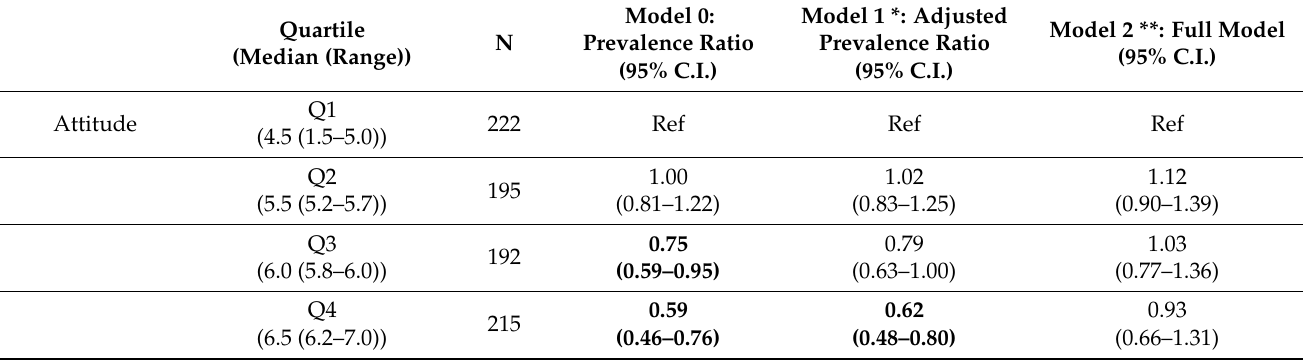
Table 3. Association between eight behavioral determinants and outcomes of the Pro55+ outcomes in bold are considered